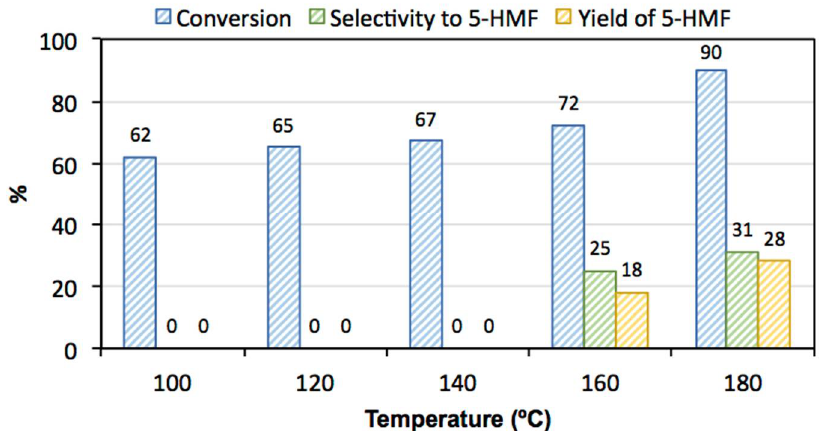
Figure 2. Effect of the reaction temperature on the catalytic activity of the catalyst MK10. Reaction conditions: 2.4 g of glucose, 0.3 g of catalyst, catalyst/glucose wt ratio = 0.125, solvent volume ratio (THF:H 2 O) = 35:15 and reaction time = 1 h.